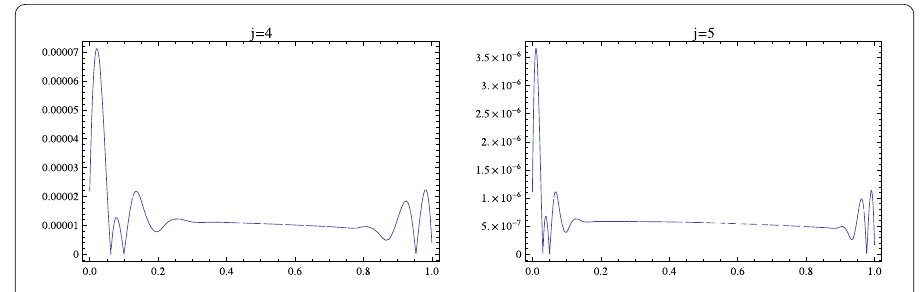
Figure 3 Absolute error plots of approximated sin( x ) in V 4 and V